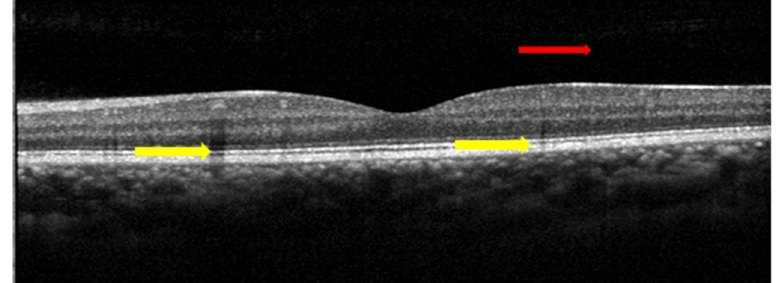
Figure 6. Shadows in OCT: blood vessels (yellow); floaters (red).